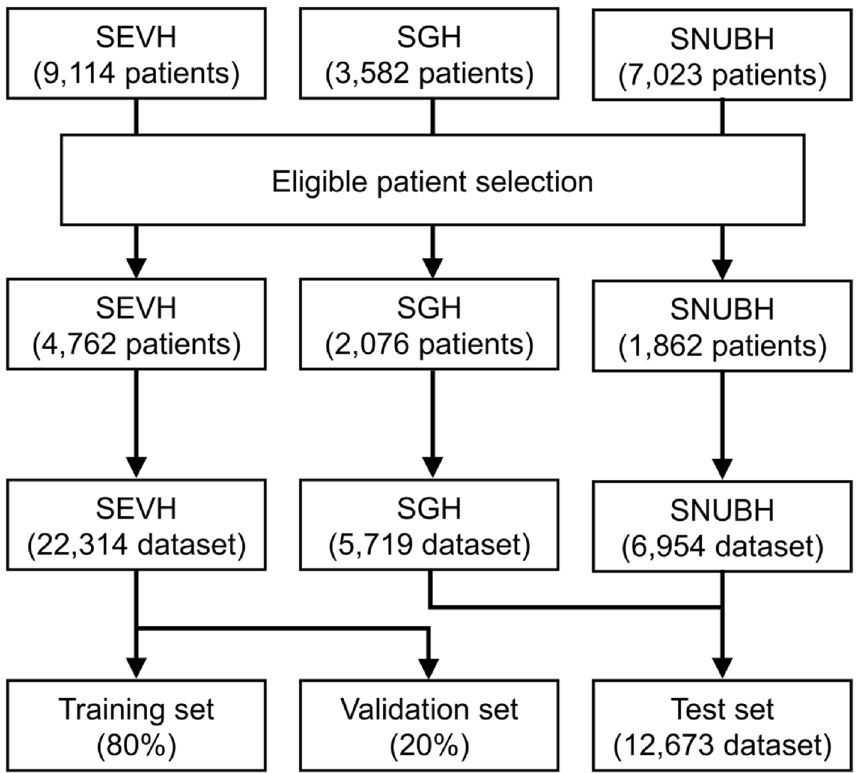
Figure 2. A diagram of how the data was prepared. SEVH Severance Hospital, SGH Sejong General Hospital, SNUBH Seoul National University Bundang